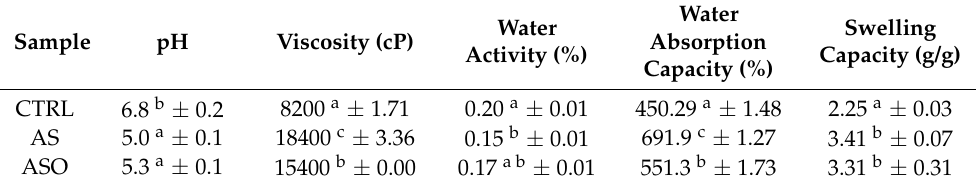
Table 3. Functional properties of the formulated complementary food (dry